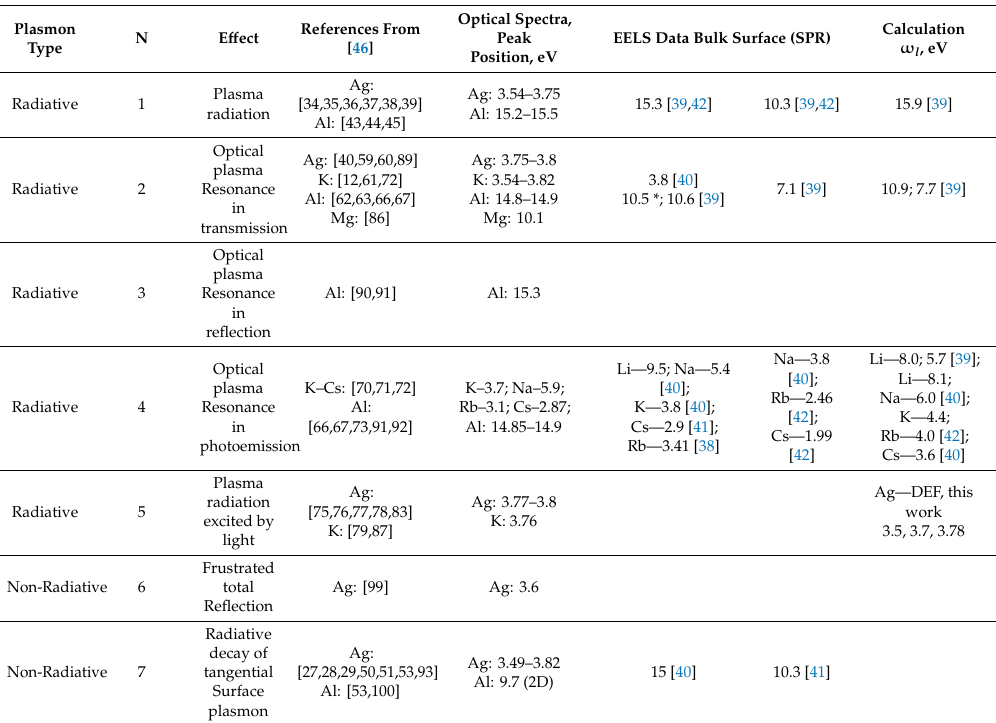
Table 3. Experimental data obtained from EELS and optical measurements for bulk and surface plasmons for simple